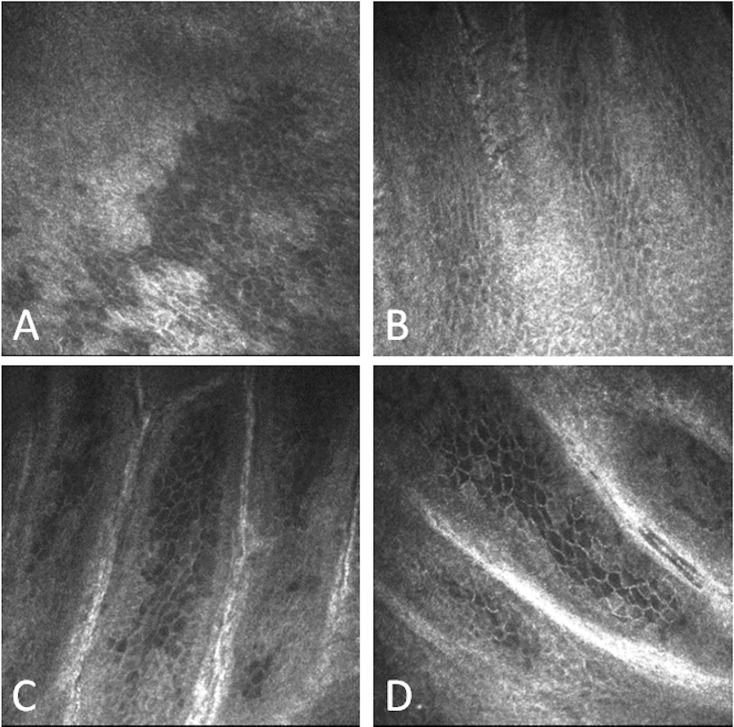
IVCM limbal features with corresponding grade.Palisades of Vogt are clearly identified as a network of radially oriented, channel-like and high reflective features located in the superficial corneoscleral limbus. A shows grade 0 (no visualization of palisades of Vogt) B shows grade 1 (low visualization of palisades of Vogt) C shows grade 2 (intermediate visualization of palisades of Vogt) D shows grade 3 (high visualization of palisades of Vogt).